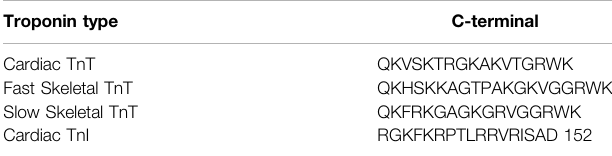
TABLE 1 | Mammalian C-terminal troponin T sequences compared with the C-terminal TnI sequence. Troponin